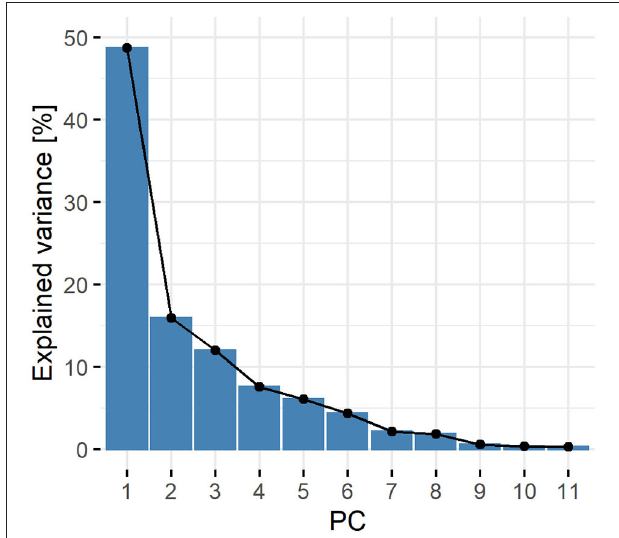
FIGURE 1 | Eigenvalue screen plot. Percentage of explained variance of the dataset covered by the principle components. For each input variable, one PC or dimension, respectively, is calculated. The percentage is derived from the proportion of the respective eigenvalue to the number of input variables ( Supplementary Table S2